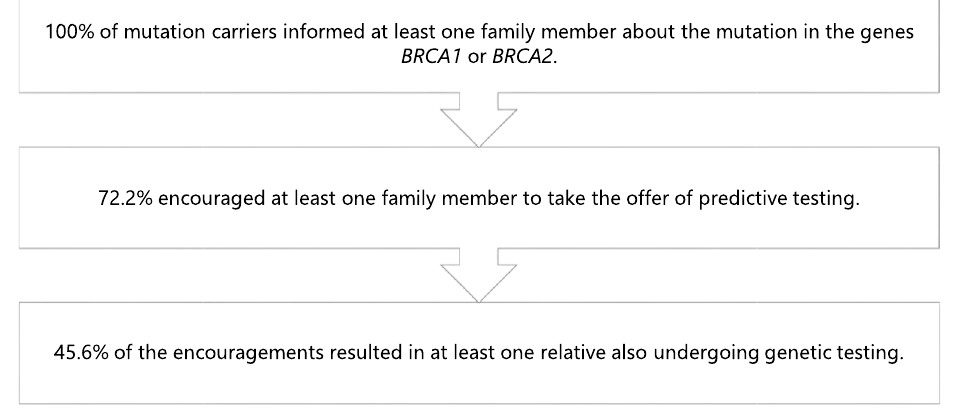
Figure 2. The familial communication process and following uptake of genetic testing.